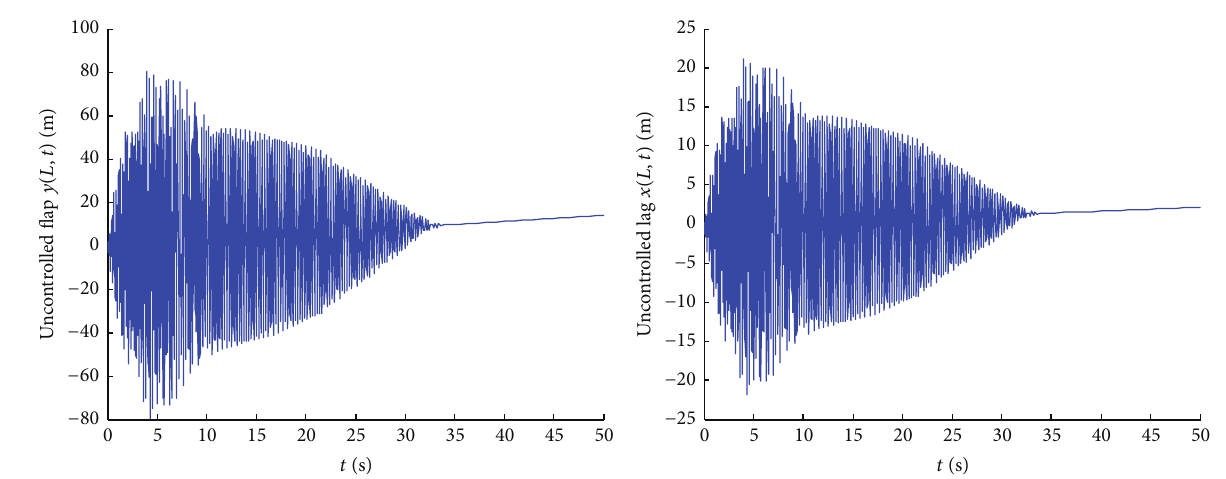
Figure 3: Uncontrolled responses of flap/lag motions under extreme wind condition of 𝑈 = 65 m/s.